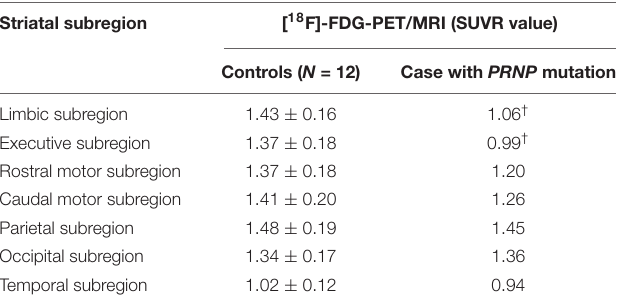
TABLE 1 | Comparison of the striatal functional distribution in this case and controls using [ 18